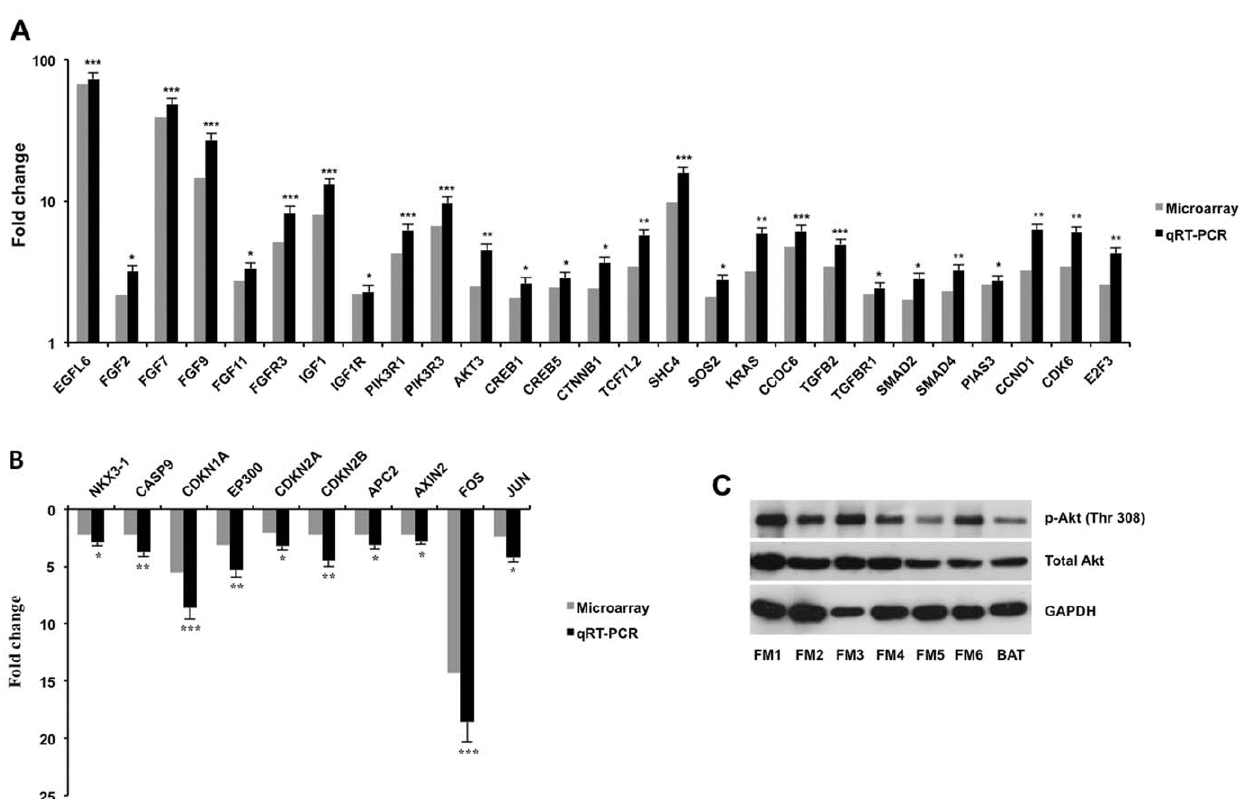
Figure 2. Expression of genes/proteins associated with the KEGG pathways in fibroblastic meningiomas and arachnoidal tissue. qRT-PCR experiments were performed to confirm the expression of genes in 10 fibroblastic meningiomas (including the 3 tested samples in microarray) and 3 arachnoidal tissues. When expression of the genes in arachnoidal tissue was set to 1, up-regulated (A) and down-regulated (B) folds of the genes in fibroblastic meningiomas are shown in each graph by using microarray and qRT-PCR. * P , 0.05, ** P , 0.01, *** P , 0.001. Western blotting determined total Akt and phosphorylated Akt (p-Akt Thr 308) in fibroblastic meningiomas and arachnoidal tissue (C). GAPDH expression was used as controls. Key words: FM, fibroblastic meningioma; BAT, brain arachnoidal tissue.